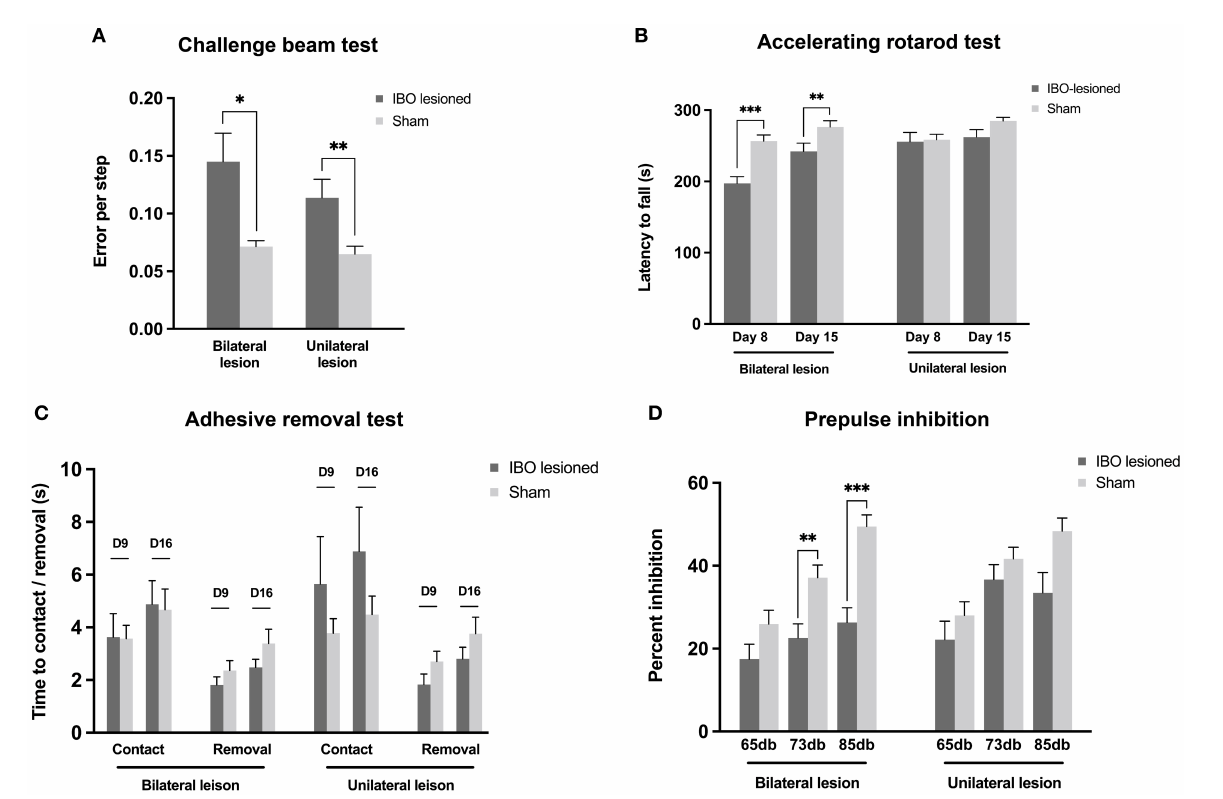
FIGURE5 Impaired skilled motor functions and sensory–motor integration following PPTg IBO lesioned. (A) Both the bilaterally and unilaterally PPTg IBO lesioned mice showed elevated error per step in the challenge beam test compared with sham mice. (B) Significantly reduced latency to fall was seen in bilateral PPTg IBO lesioned mice at day 8 and day 15, while no difference was found between unilateral lesioned and sham mice in accelerating rotarod test. (C) No difference was found for time to contact and removal of the adhesive sticker on the snot between PPTg lesioned and sham mice at day 9 and day 16. (D) Decreased inhibition of prepulse stimulation was found in the bilateral PPT IBO lesioned mice at 73 db and 85 db, while no difference was seen between unilateral PPTg lesioned and sham group. * P < 0.05, ** P < 0.01, *** P <